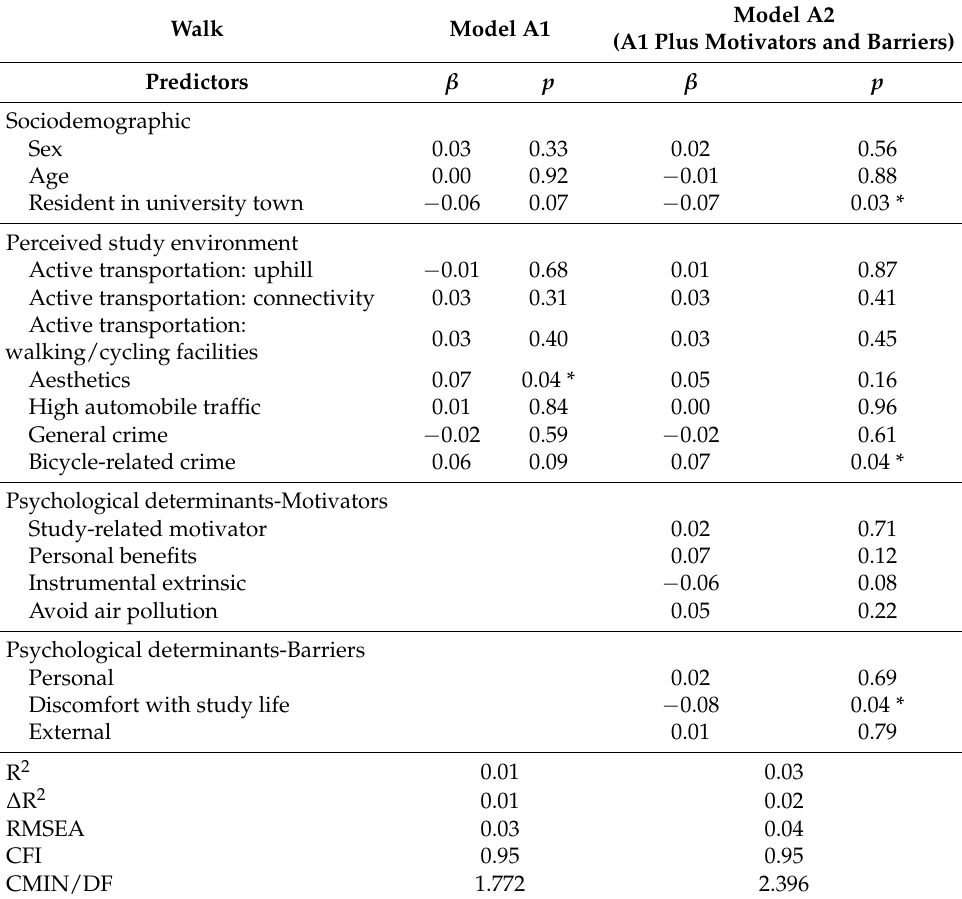
Table 2. Results of the blockwise multivariate regression models A1 (predictors—sociodemographics, and perceived study environment) and A2 (A1 plus motivators and barriers) for the active trans- portation by walking. Model A2 Walk Model A1 (A1 Plus Motivators and